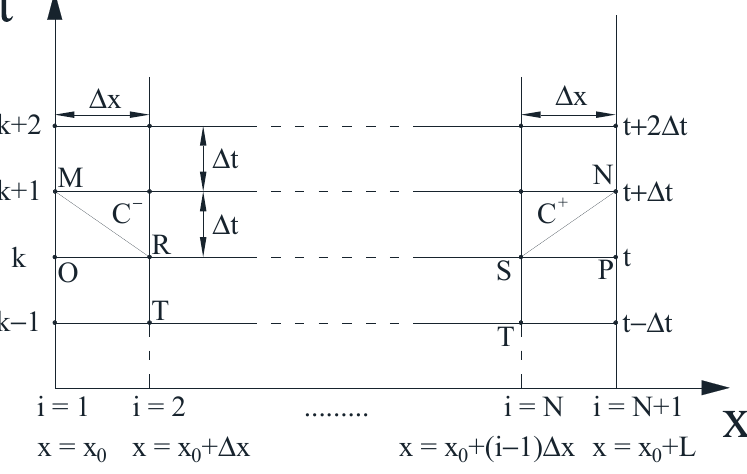
Figure 2. Boundary Figure 2. Boundary conditions.